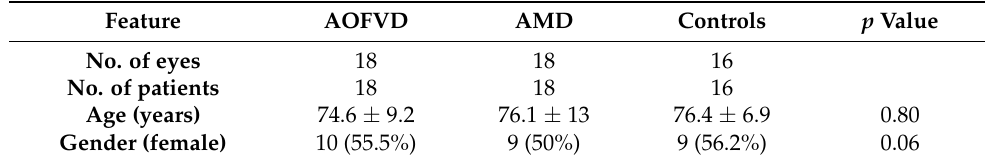
Table 1. Baseline characteristics of the overall population.